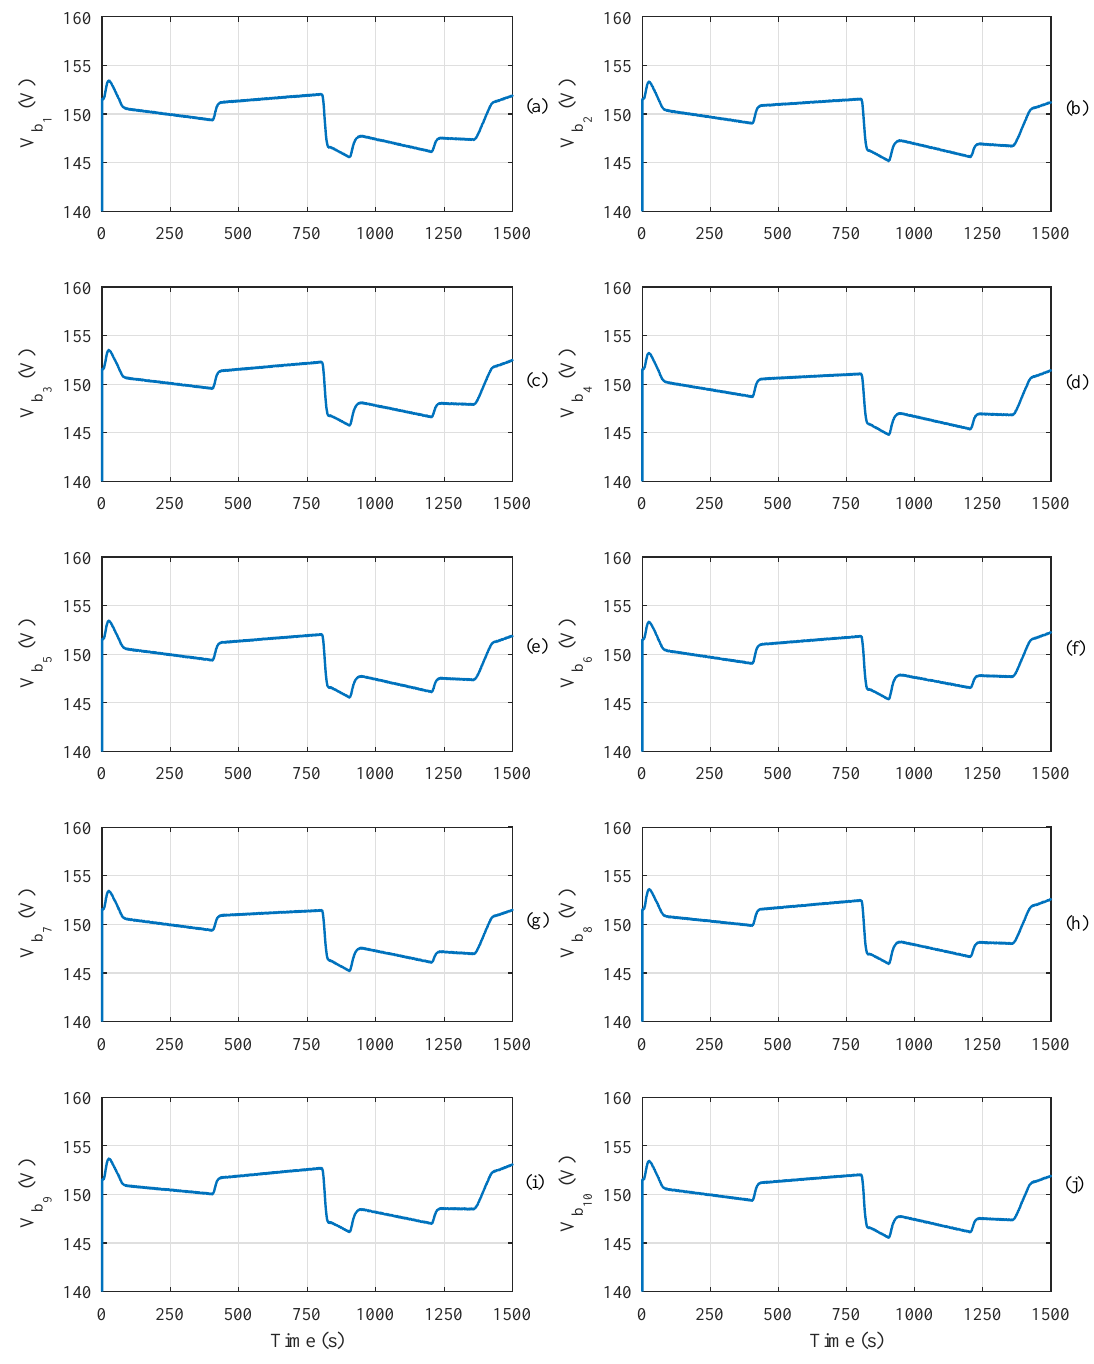
Figure 22. Voltages of the banks of batteries the 10 hybrid energy storage systems (HESSs). ( a ) v b ( b ) v b ; ( c ) v b ; ( d ) v b ; ( e ) v b ; ( f ) v b ; ( g ) v b ; ( h ) v b ; ( i ) v b ; and ( j ) v b 2 3 5 6 7 8 9 4